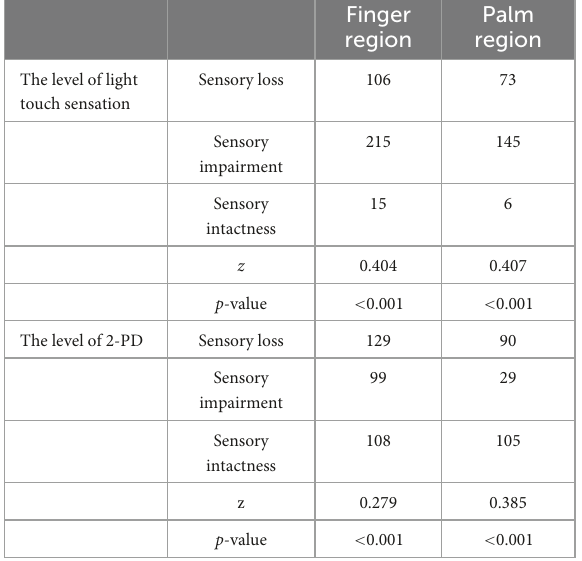
TABLE 2 The level of sensory in the finger and the palm region.